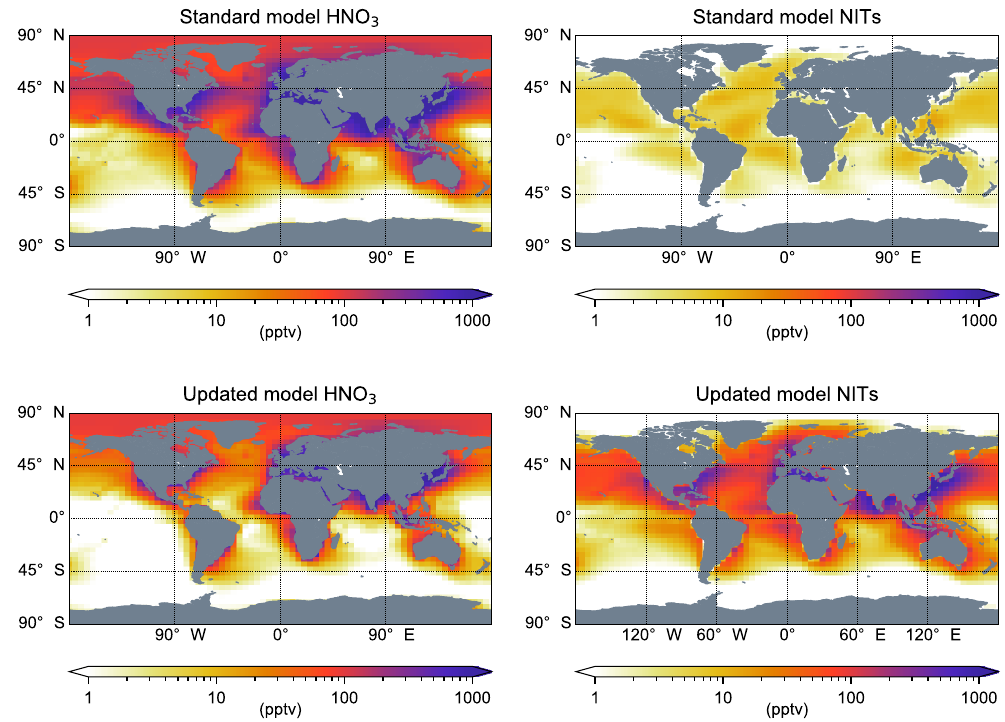
Figure 2. Simulated 2014–2015 MBL-average (average over bottom 1km) HNO 3 and NITs (p-NO 3 associated with coarse-mode SSA) for the standard and updated